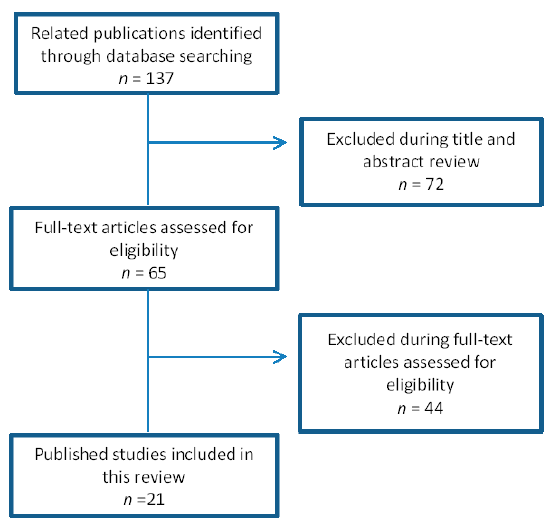
Figure 1. Research strategy on digital library databases.